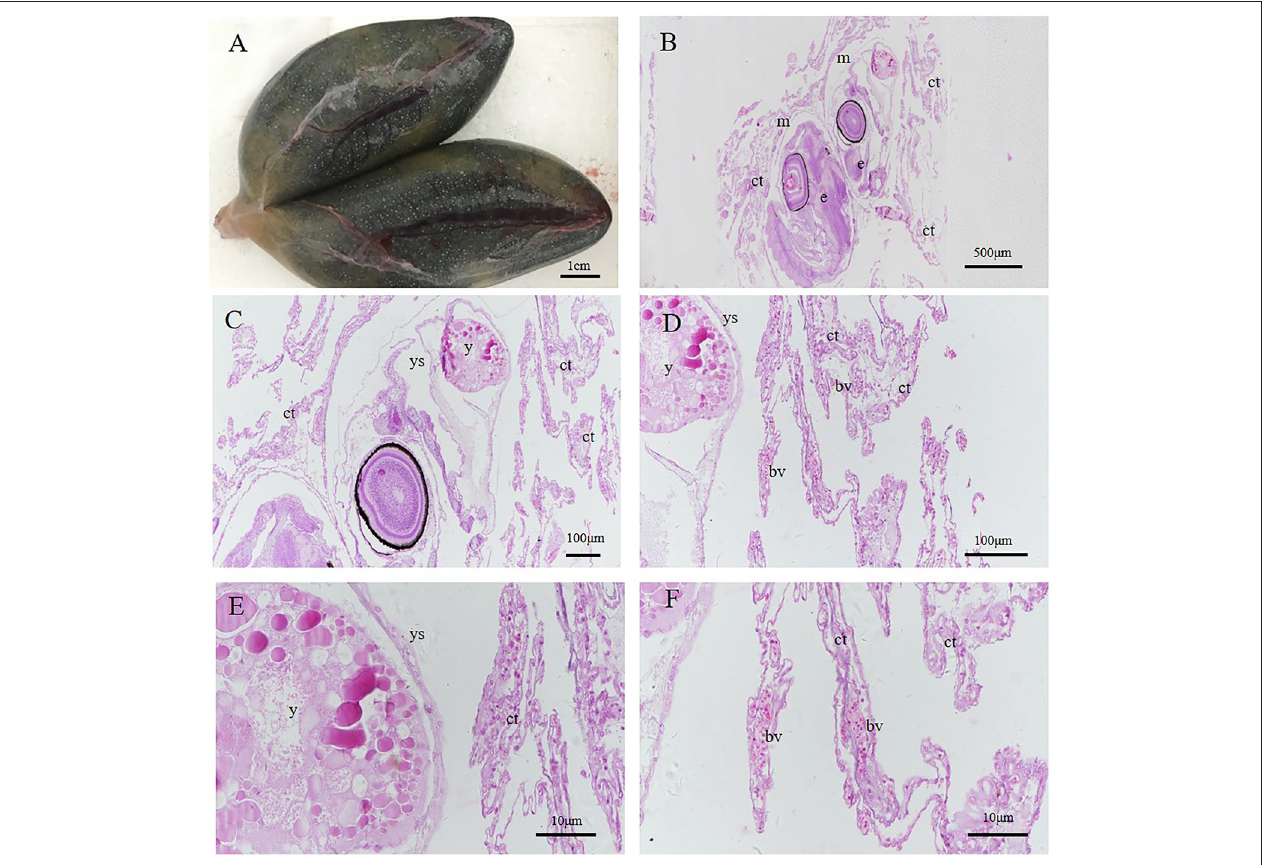
FIGURE 10 | S. schlegelii , embryos in the organ forming stage. (A) Black ovaries during organogenesis. (B) The embryo is located in the egg membrane (m) with loose connective tissue (ct) outside. (C) An embryo containing yolk. (D,E) Yolk in the yolk sac (ys). (F) Numerous blood vessels (bv) in the connective tissue (ct). Scale bars, 1cm (A) ; 500 µ m (B) ; 100 µ m (C,D) ; 50 µ m (E,F) . HandE